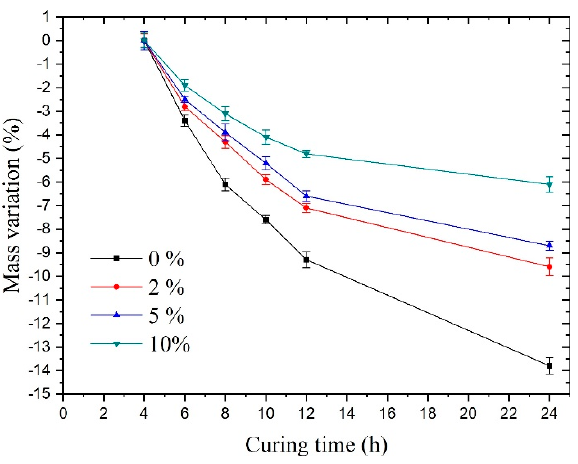
Figure 8. Mass variation under sulfate solutions with different concentrations .